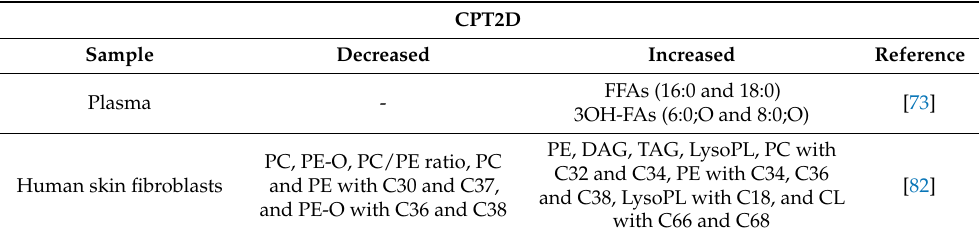
Table 5. Main changes in lipids in plasma and skin fibroblasts of carnitine palmitoyl transferase type 2 deficiency (CPT2D) patients reported in published studies a